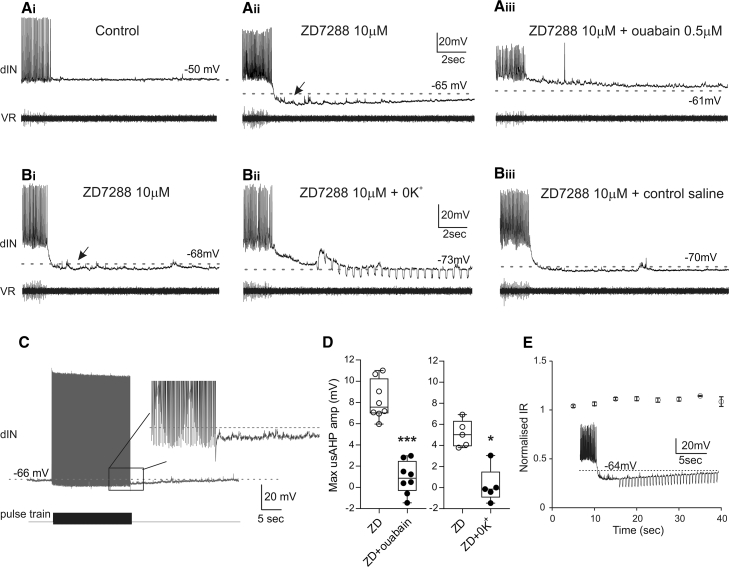
Blocking Ih Revealed a Post-swim usAHP(A) Following dIN firing in control, (Ai) the membrane potential repolarized to the baseline. (Aii) In the presence of 10 μM ZD7288, the RMP hyperpolarized (dashed line) and a long-lasting AHP appeared following the end of a swimming episode. (Aiii) The usAHP was abolished after adding 0.5 μM ouabain in the bath.(B) Another dIN displayed a usAHP in the presence of ZD7288 (Bi). Removing K+ ions from saline abolished the usAHP (Bii). After replacing 0K+ saline with control saline, the usAHP reappeared (Biii). Dotted lines in (A) and (B) indicate the resting membrane potentials. Downward deflections in (Bii) are conductance pulses.(C) A train of depolarizing pulses that mimics swimming was applied to dINs following ZD7288 treatment. A small afterhyperpolarization was observed in some dINs (8 out 12), which was never observed in control (see Figure 1Di).(D) Pooled data indicate that the maximum amplitude of usAHP was reduced significantly by 0.5 μM ouabain (left panel; n = 8; ∗∗∗p < 0.001) or 0K+ saline (right panel; n = 5; ∗p = 0.011). Data are expressed as median with 50% IQR and displayed as box-and-whisker plots with individual data points.(E) The input resistance (IR) during the usAHP period was tested and plotted against time. The inset shows an example of current pulses injected during usAHP period. Pooled data indicate that there was no significant change in input resistance during the usAHP (n = 3; one-way ANOVA; p = 0.26; mean ± SD).